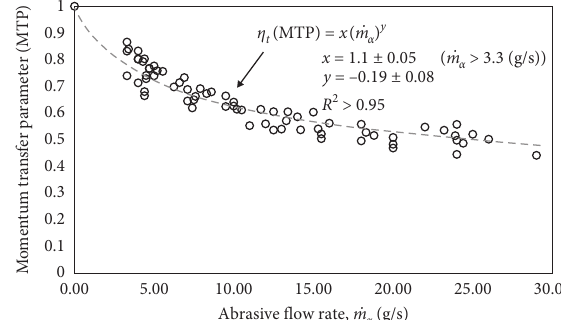
Figure 13: Momentum transfer parameter as a function of the abrasive flow rate in granite cutting.